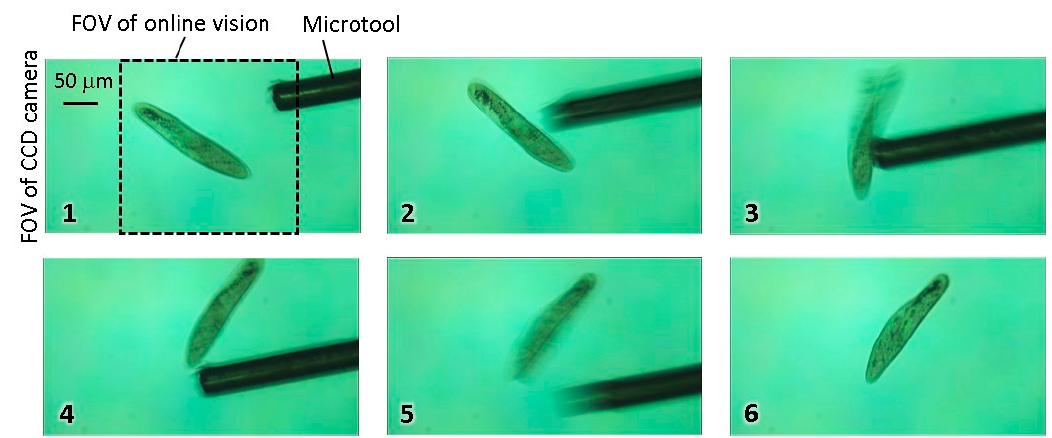
Figure 10. Swimming path of single Paramecium during 31 min and 15 s of target tracking. Maximum swimming speed of the Paramecium was approximately 2 mm/s.